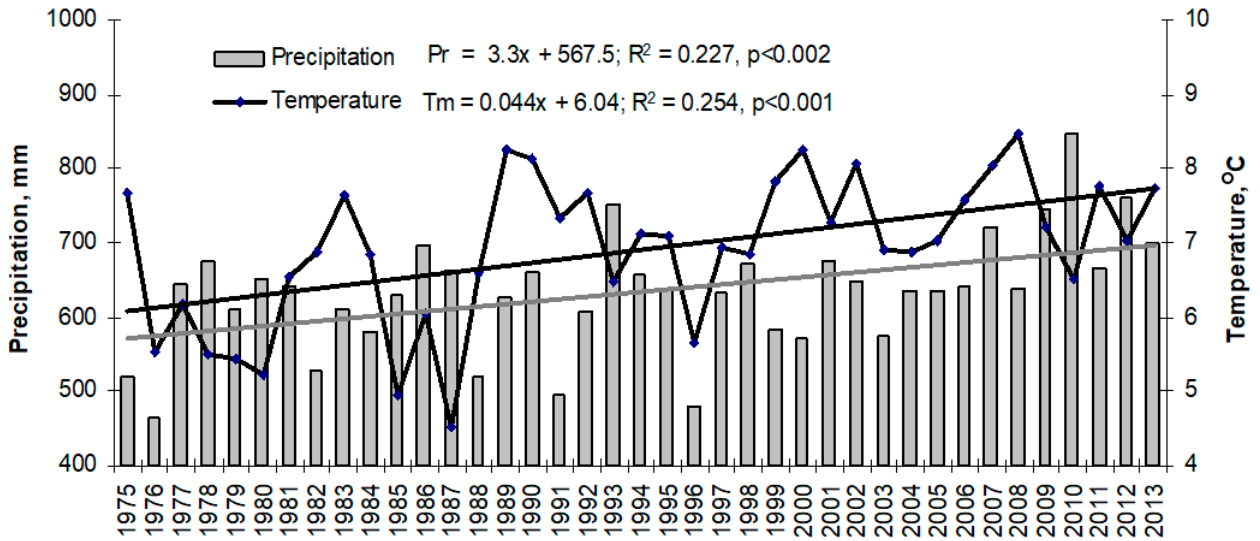
Figure 2. Variation in annual mean daily temperature and mean precipitation sum in the Kaunas region from 1975 to 2013 (data received from the Kaunas region meteorology station).